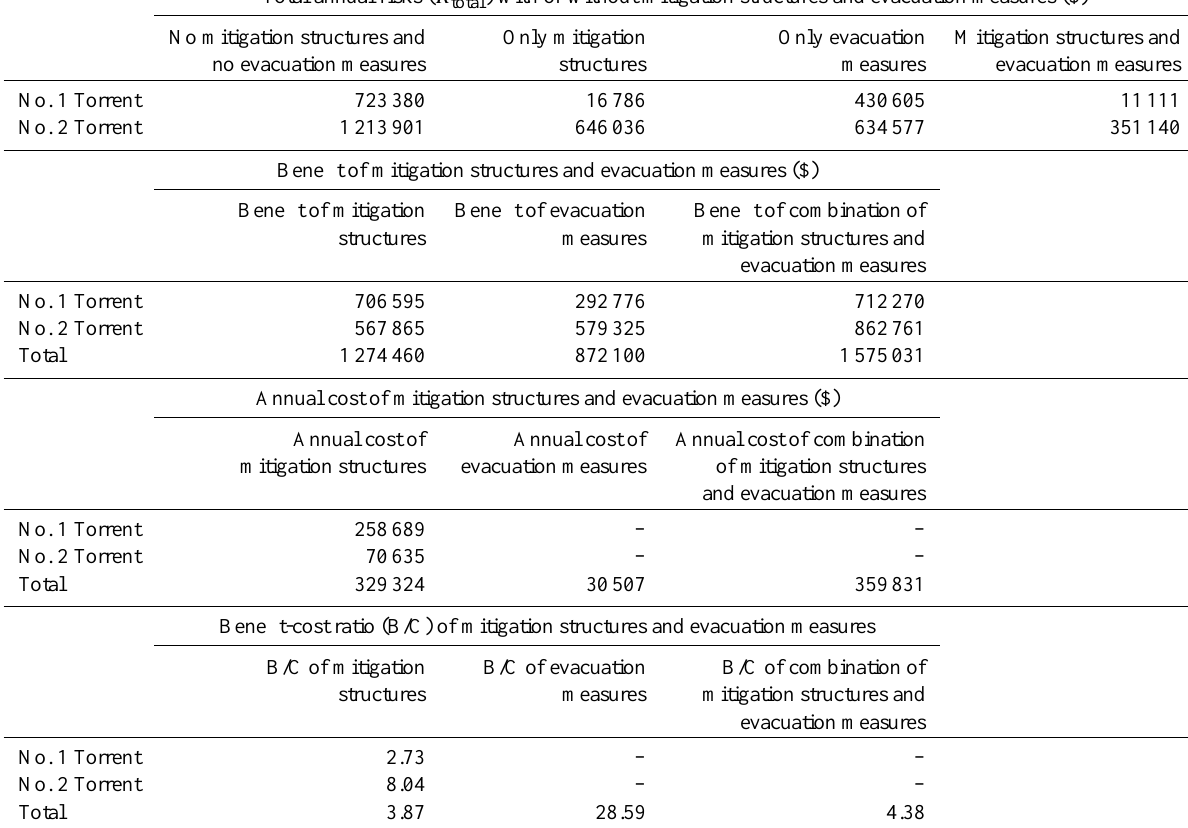
Table 6. Total annual risks, benefits, annual costs, and the benefit-cost ratio when mitigation structures are combined with evacuation measures for the Nos. 1 and 2 Torrents.